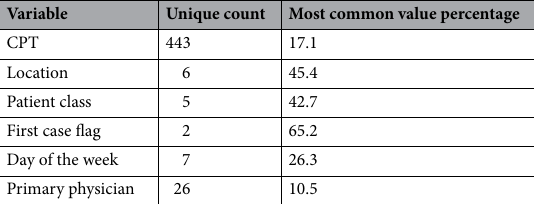
Table 3. Categorical variable distributions.